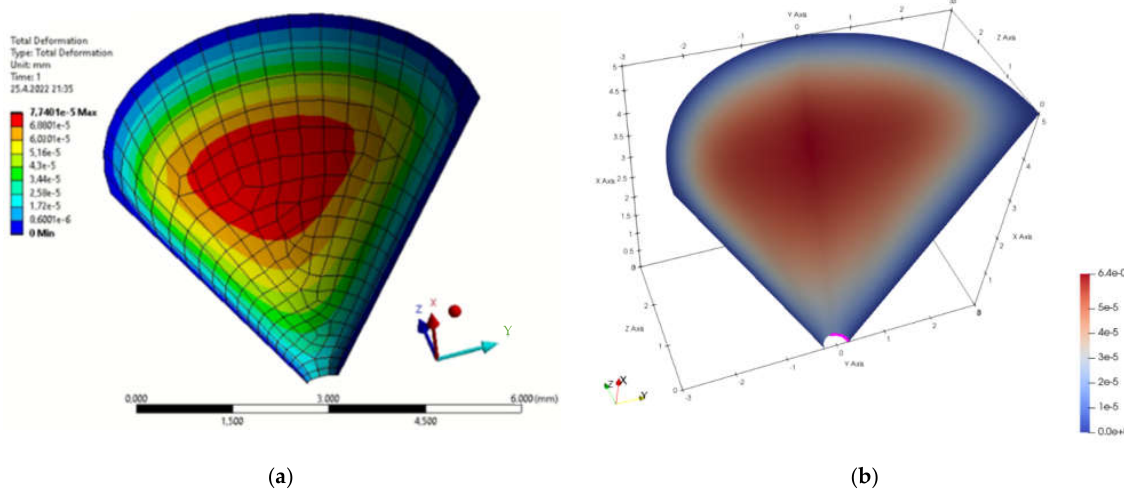
Figure 7. Total displacement field ( a ) FEM program; ( b ) MATLAB.